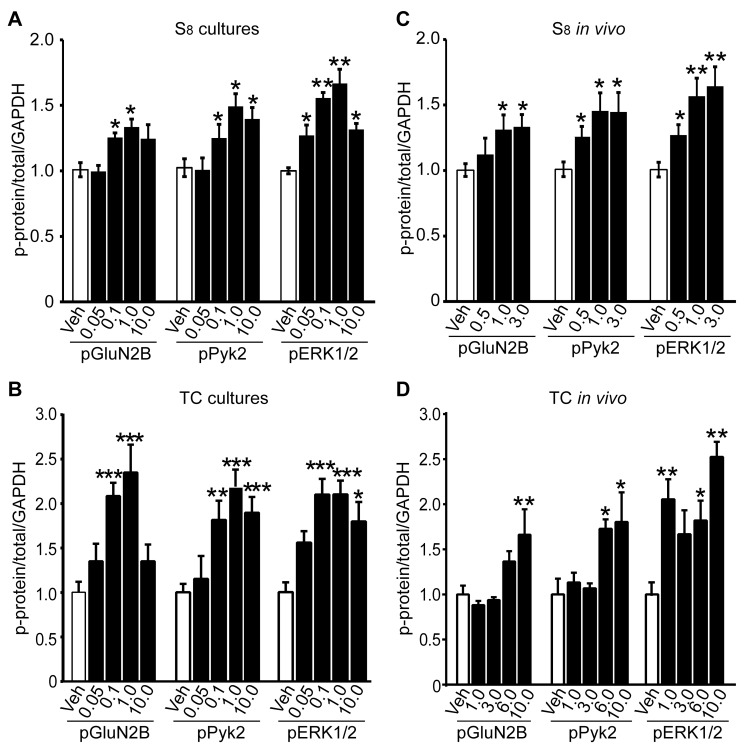
S8 and TC-2153 increases the Tyr phosphorylation of STEP substrates in neuronal cultures and in vivo.Cortical neuronal cultures were treated with (A) S8 and vehicle (Veh) or (B) TC-2153 and vehicle (0.05, 0.1, 1, and 10 µM) for 1 h. Phosphorylation of GluN2B (Y1472), Pyk2 (Y402), and ERK1/2 (Y204/187) were significantly higher after treatment of cultures with S8 (A) or TC-2153 (B) (*p<0.05, **p<0.01, ***p<0.001, one-way ANOVA with post hoc Bonferroni test). Data represent the phospho-signal normalized to total protein and then to GAPDH (mean ± s.e.m., n = 4). C57BL/6 mice (3–6 mo) were injected with (C) S8 (0.5, 1, 3 mg/kg, i.p.) or (D) TC-2153 (i.p., 1, 3, 6, 10 mg/kg, i.p.) and were sacrificed 3 h later. Cortices were microdissected and lysates spun down to P2 fraction and prepared for Western blotting. Tyrosine phosphorylation status was probed with phospho-specific antibodies to pGluN2B: Tyr1472, pPyk2: Tyr402, and pERK1/2: Tyr204/187 (*p<0.05; **p<0.01; one-way ANOVA with post hoc Bonferroni test). Data represent the phospho-signal normalized to the total protein signal and then to GAPDH (mean ± s.e.m., n = 3).